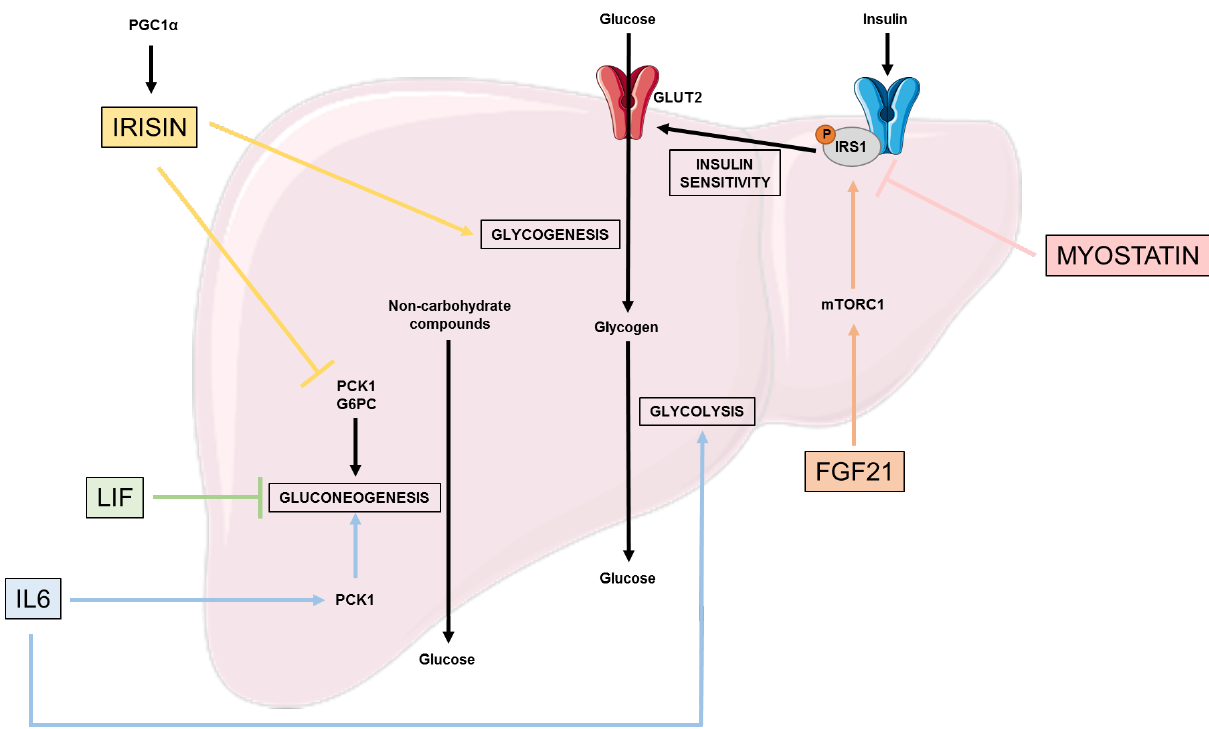
Figure 1. Effects of myokines on glucose metabolism. This figure represents the beneficial and deleterious effects of different myokines on the different pathways involved in glucose metabolism: insulin sensitivity, glycogenesis, glycolysis, and gluconeogenesis. FGF21: Fibroblast growth factor 21; G6PC: Glucose-6-phosphatase catalytic subunit; GLUT2: Glucose transporter 2; IRS1/2: Insulin receptor substrate 1/2; LIF: Leukemia inhibitory factor; mTORC1: Mammalian target of rapamycin complex 1; PCK1: phosphoénol pyruvate carboxykinase; PGC1α: Peroxysome proliferator-activated receptor gamma co-activator 1-alpha.